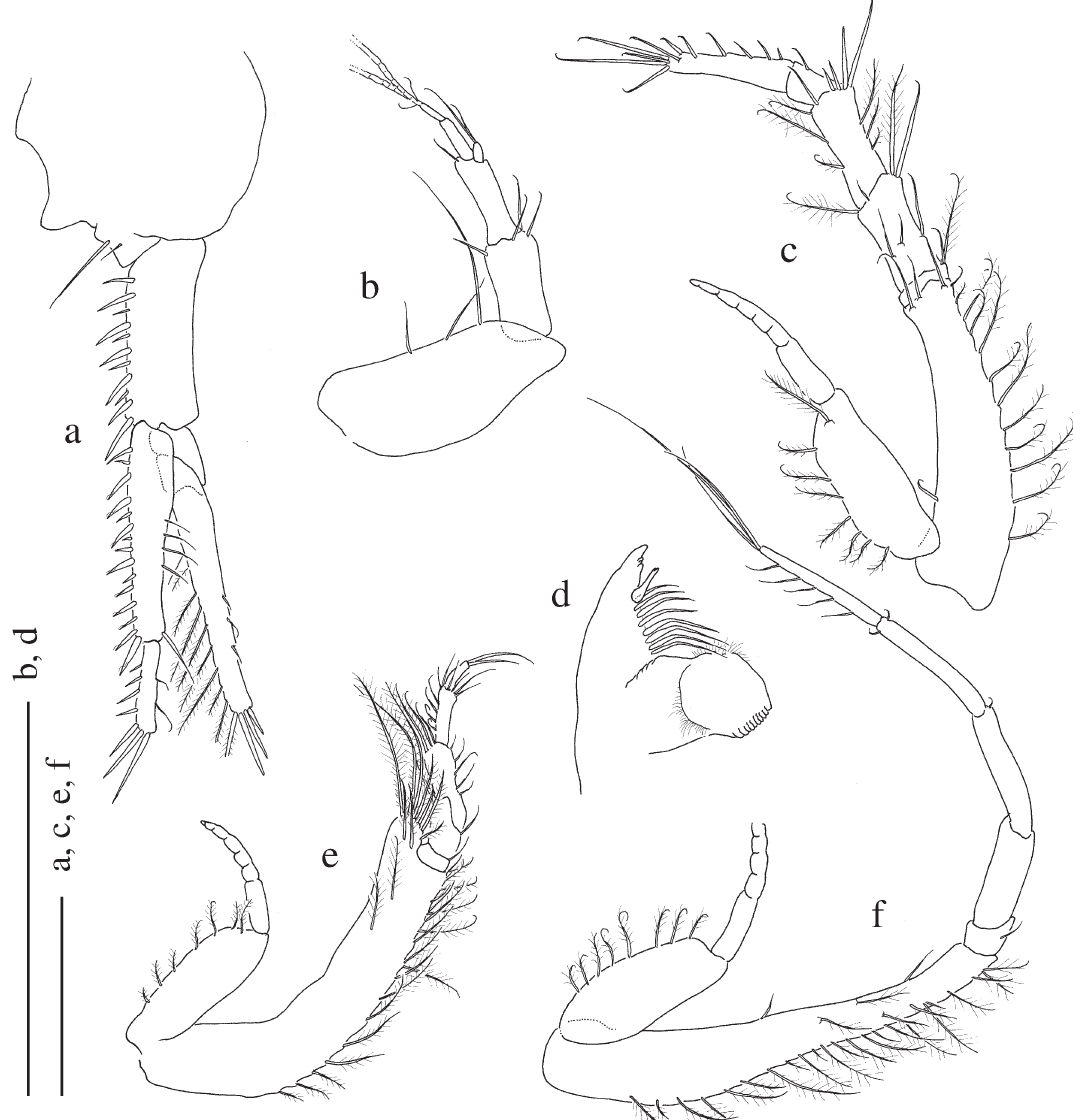
Description: Ovigerous female 6.75 mm total length (from the tip of pseudorostrum to the end